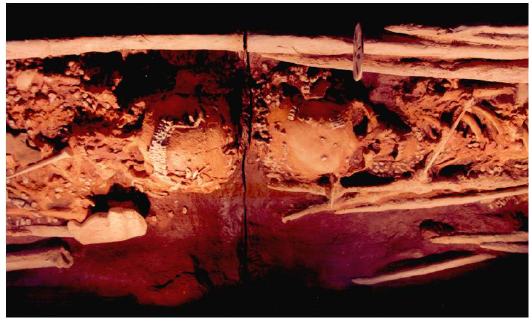
Figure 2. Sungir C2 and C3 individuals